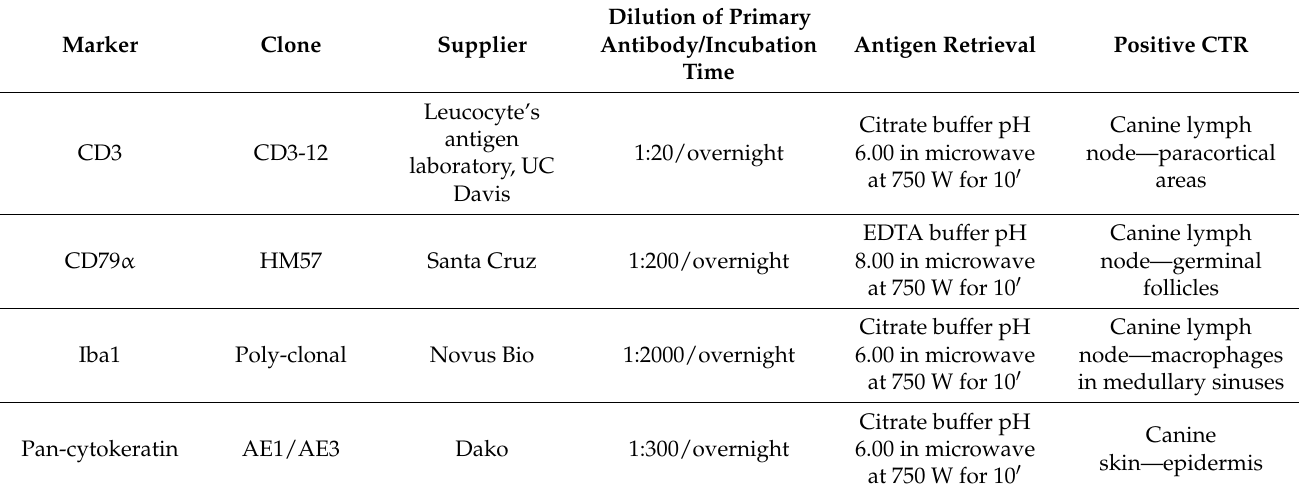
Table 1. Information on immunohistochemical reagents and